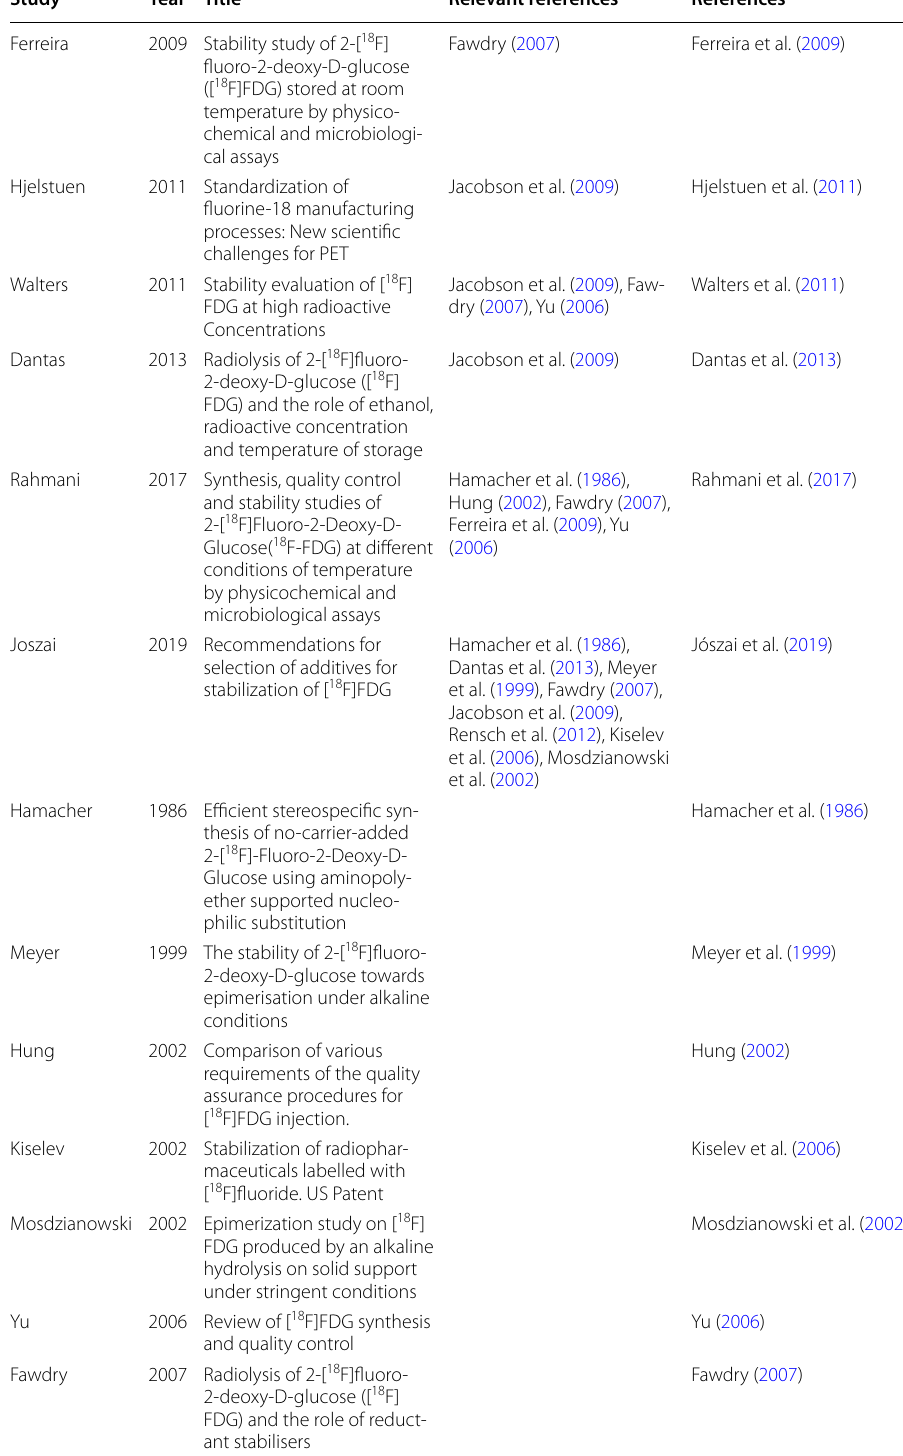
Table 2 Results from the primary literature study and relevant references